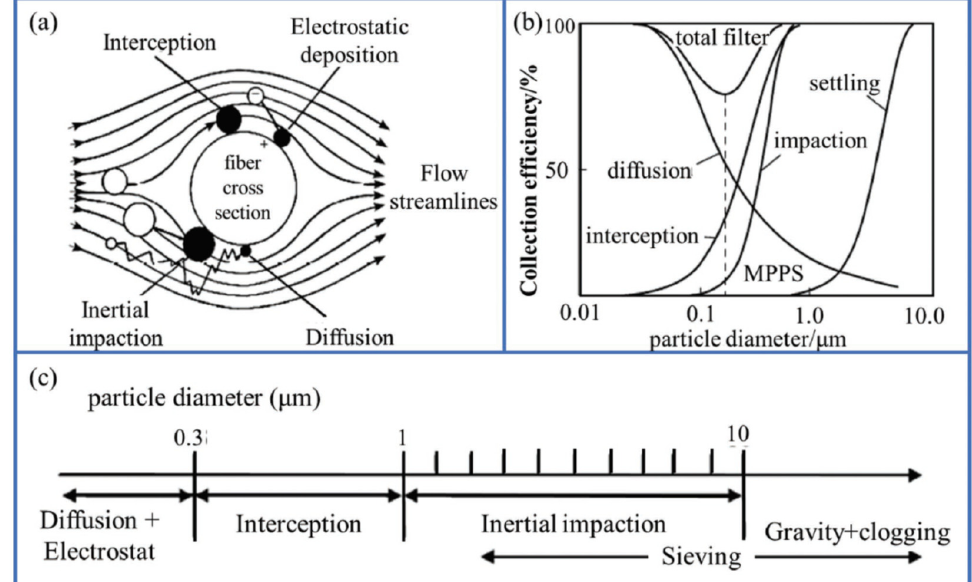
Figure 5. Predominant filtration mechanism depending on particle size( a ) the schematic of the main filtration mechanism of a fiber ( b ) the filtration efficiency for each filtering mechanism as well as the overall efficiency ( c ) dominant filtration effect based on the particle size. (Reprinted with permission overall efficiency ( c ) dominant filtration effect based on the particle size (Reprinted with permission from [21]. Copyright 2017 John Wiley & Sons.). from [21]. Copyright 2017 John Wiley &